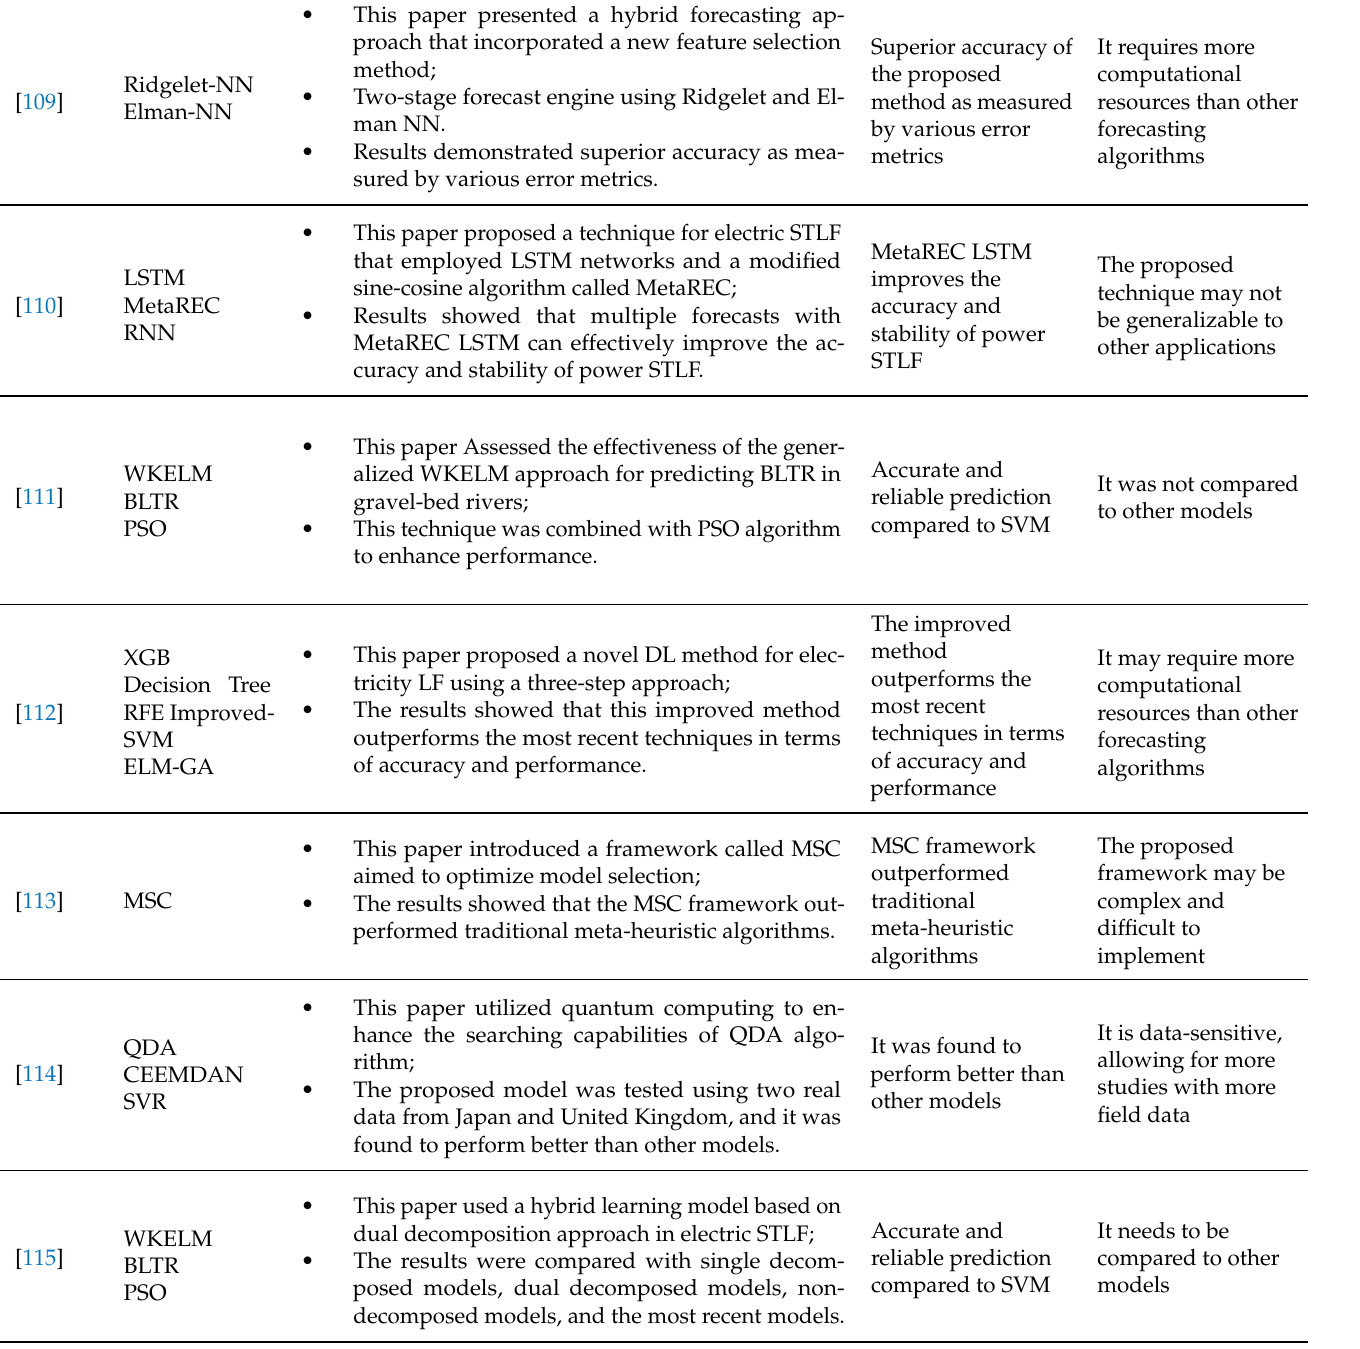
Table 6. Summary of meta-heuristic based load forecasting techniques.